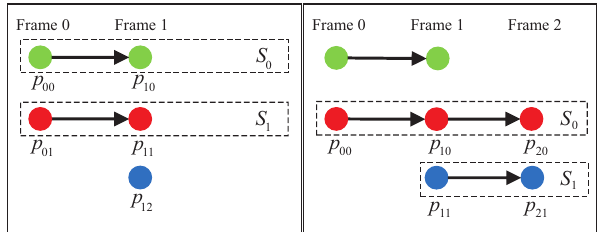
Fig. 4 Feature correspondence lists for frame 1 (left) and frame 2 (right). To construct the FCL for frame 2, we remove point sets with unmatched features (green), add matched points whose corresponding features are in the previous frame’s FCL into the corresponding point sets (red), and add new point sets for matched features whose corresponding features are not in the previous frame’s FCL (blue). Finally we re-index all points in the FCL. The number of point sets in the two FCLs is the same; here m 1 = m 2 =